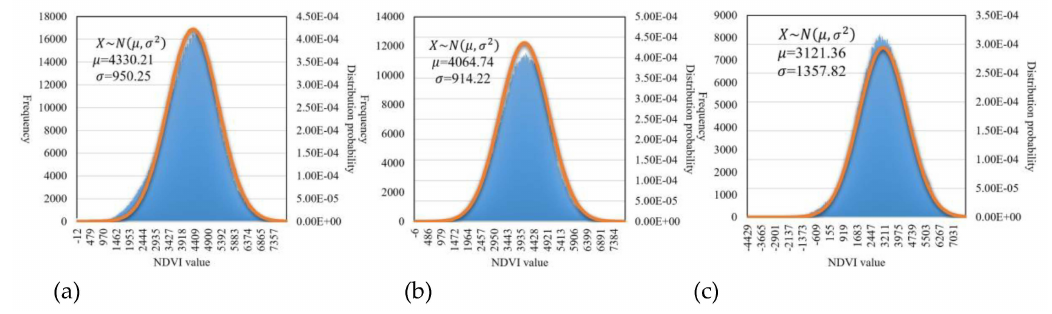
Figure 7. NDVI distributions and PDFs of soybean ( a ), maize ( b ), and others ( c ) on DOY 180.